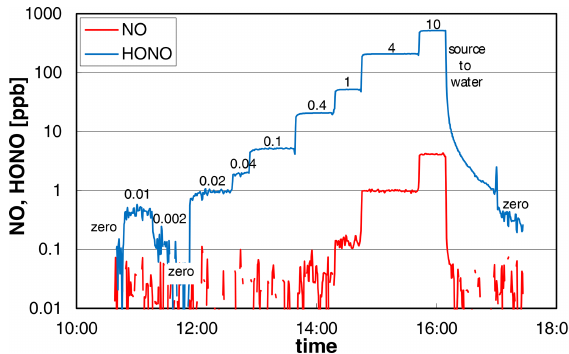
Figure 3. NO and HONO concentrations of the HONO source (logarithmic scale) for variable nitrite concentrations (numbers in the figure in mgL − 1 ). The HONO signal of the chemilumi- nescence instrument shows significant tailing for zero measure- ments, which follow high HONO concentrations (see last zero). ∅ , dry = 2104cm 3 min − 1 , Experimental conditions: T = 15.9 ◦ C, φ g 20rpm, pH =